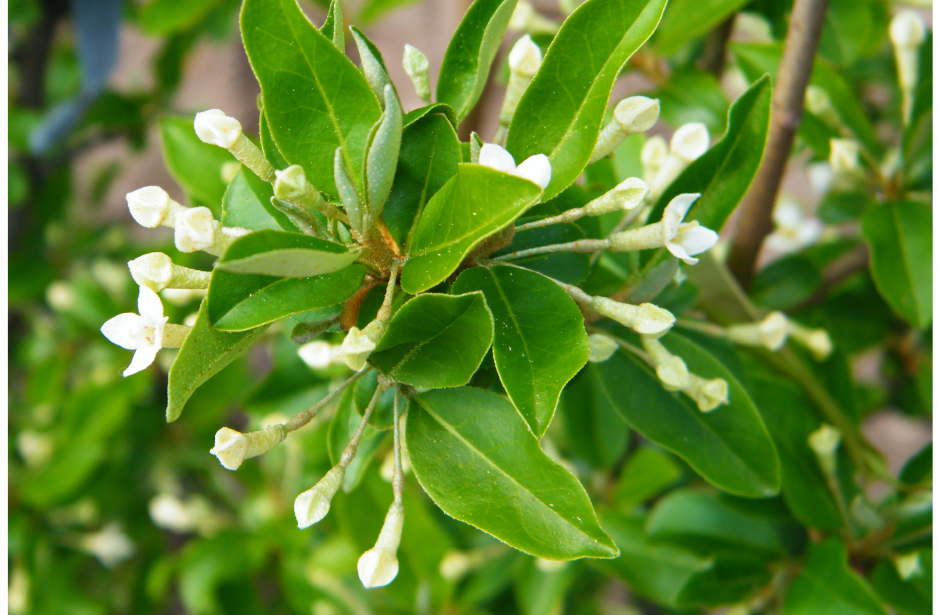
Figure 3. Elaeagnus multiflora shoot during the flowering period.